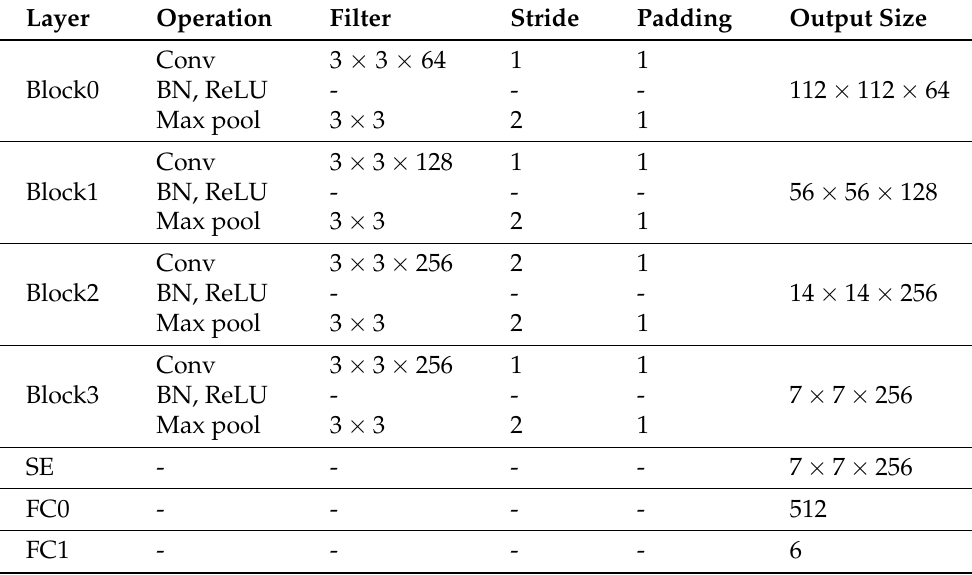
Table 1. The detailed structure of our classification